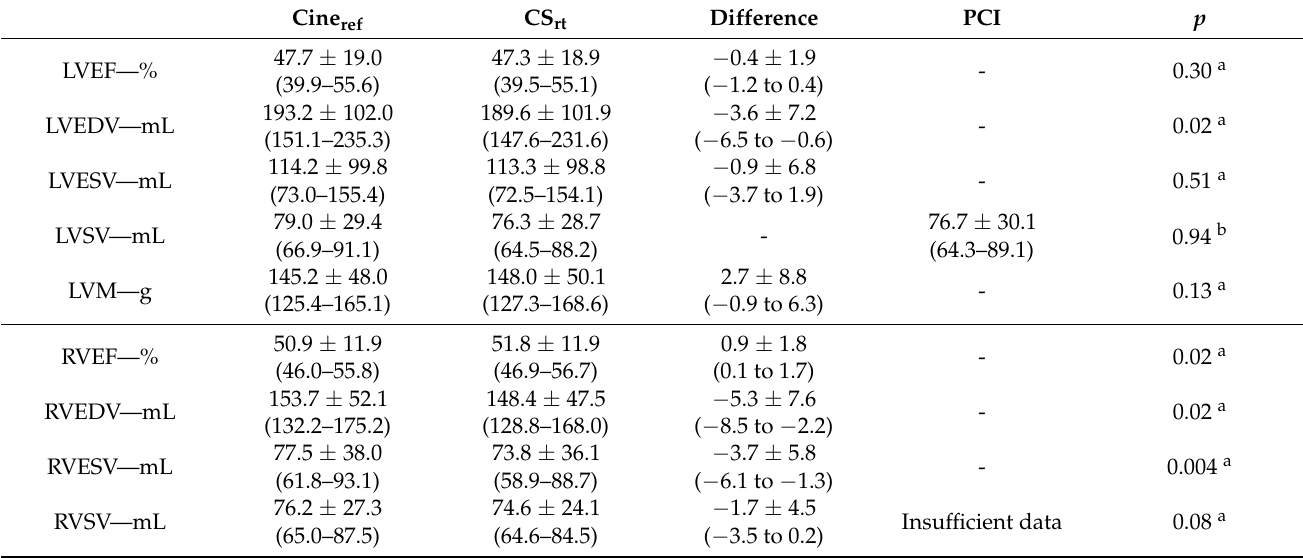
Table 4. Biventricular functional assessment of the study population.